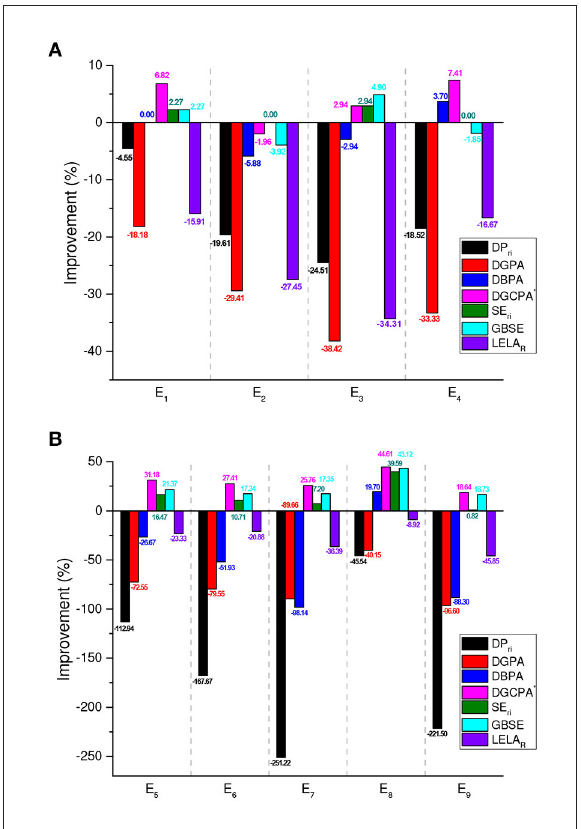
FIGURE3 Convergence rate improvements of the compared algorithms relative to PFLA in benchmark environments, calculated by using Iterations {PFLA} − Iterations {ComparedAlgorithm} . (A) Two-action environments. Iterations {PFLA} (B) Ten-action